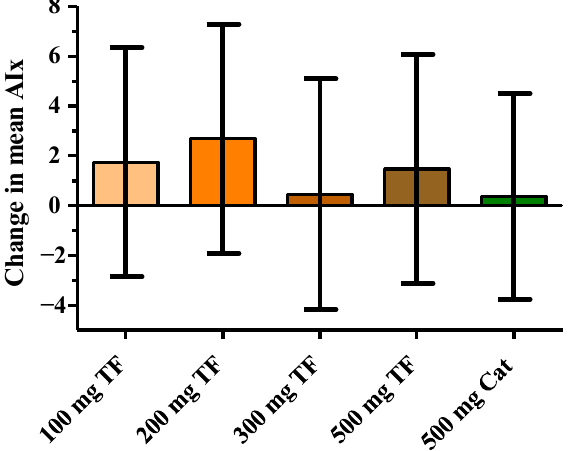
Figure 2. Effect of 100, 200, 300 and 500 mg theaflavins (TF) and 500 mg catechin (Cat) on augmentation index (AIx); data are presented as change to placebo of the mean of time points t = 2, 4 and 6 h after test product intake with t = 0 as covariate. Values are expressed as LSmeans and 95% CIs.